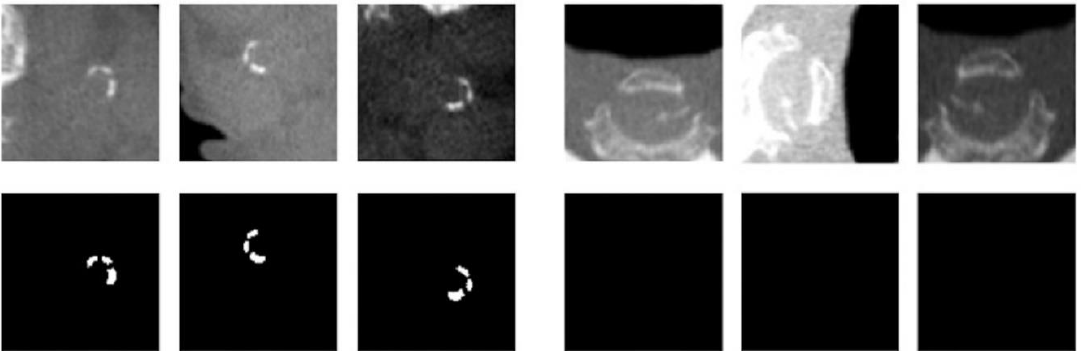
Figure 4. A sample of data augmentation for regions with and without calcification ( first row ) and their corresponding masks ( second row ).